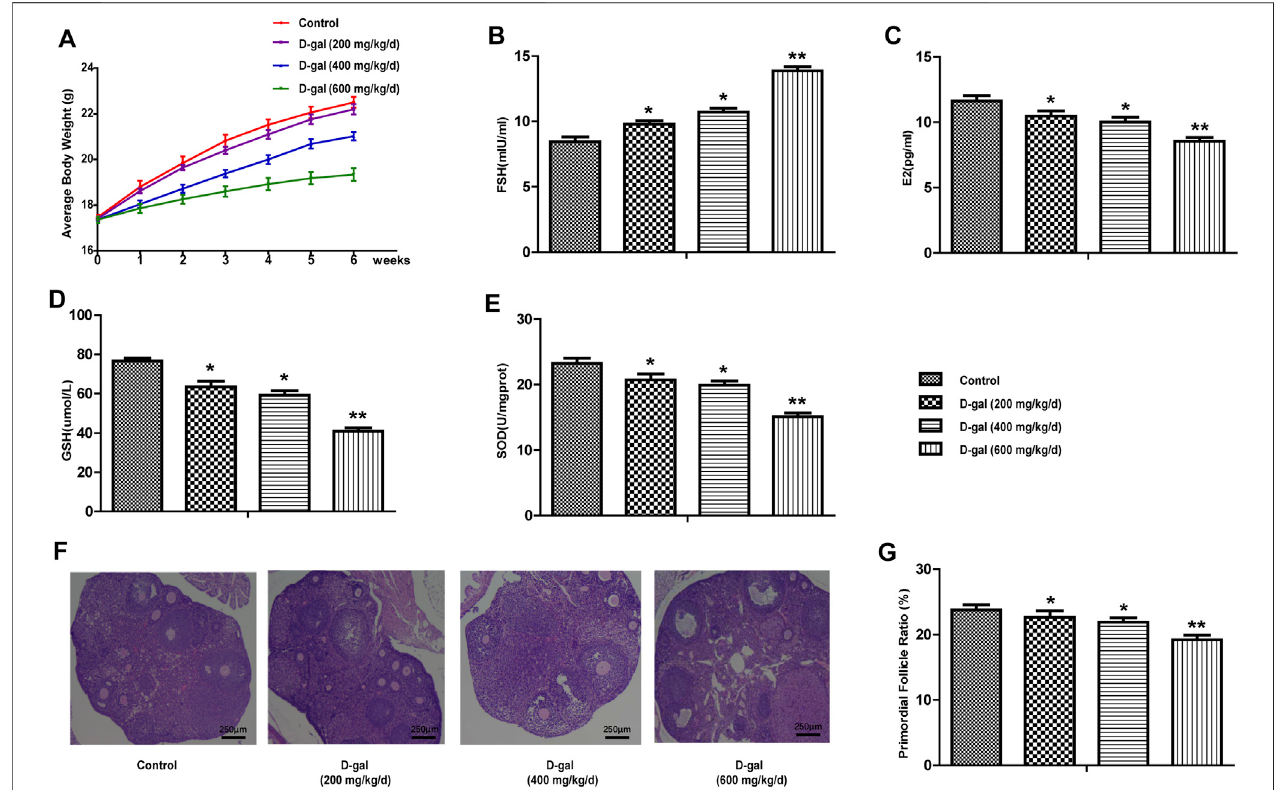
FIGURE 1 | Establish a mouse model of POF. (A) The body weight changes of mice in control and D-gal group (low, middle and high dose) were recorded during the process of inducing the POF model. (B,C) The serum FSH and E2 levels were tested in four groups. (D,E) The levels of GSH and SOD in the ovarian tissues were tested. (F,G) The proportion of primordial follicle. All data are shown as means ± SEMs, n = 5. Statistical signi fi cance: * p < 0.05, ** p < 0.01.